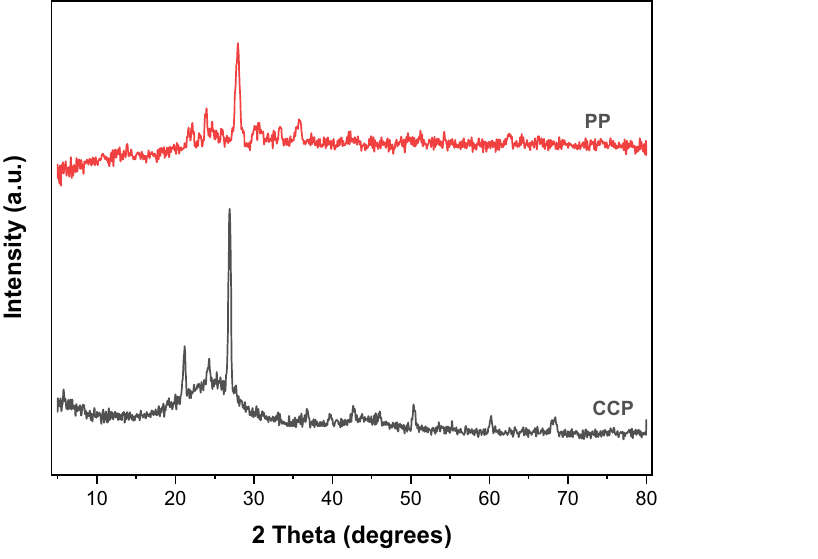
Figure 3. XRD analysis of PP and CCP powders.